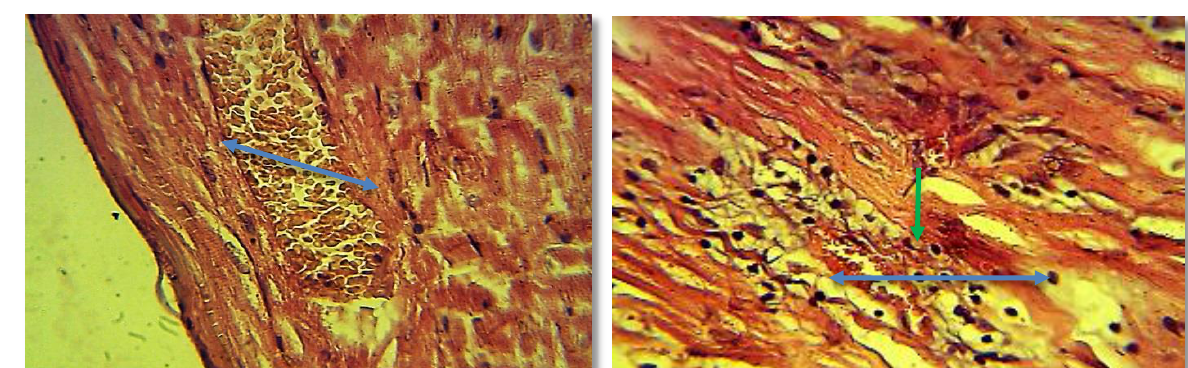
Figure,3: Section in the cardiac muscle of rabbit treated with methionine over load (T1) for 42 days show edema and severe congestion of blood vessels between cardiac muscle cells (H &E stain 40X).